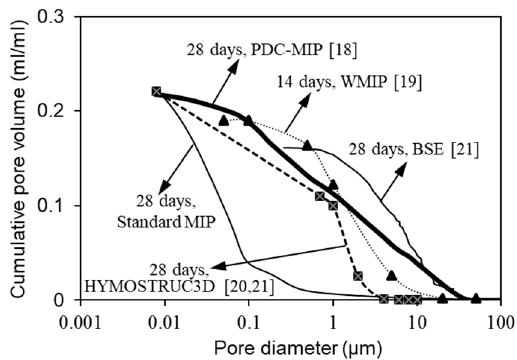
Figure 4. Comparison of pore size distribution between standard MIP, PDC-MIP, WMIP (wood’s metal intrusion porosimetry), BSE (backscattered electron image) and HYMOSTRUC3D (hydration, morphology and structure 3-dimensional formation).